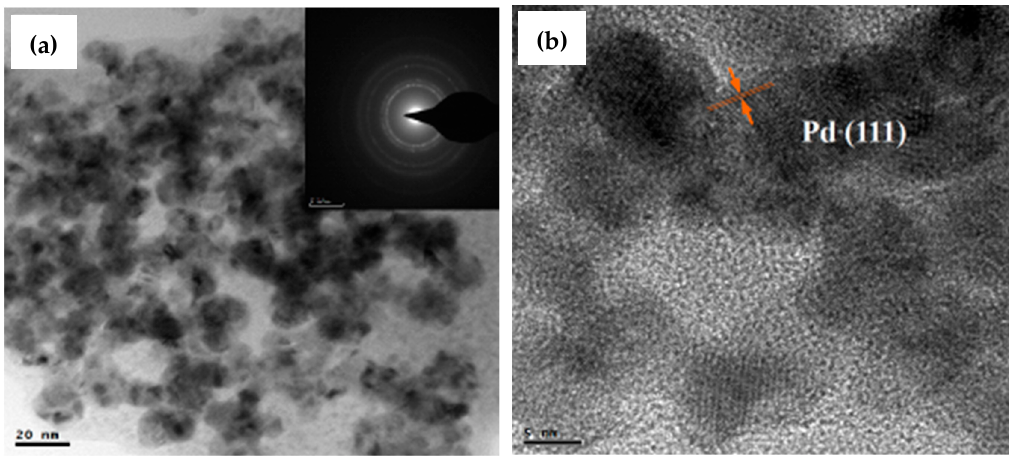
Figure 5. TEM ( a ) and HR-TEM ( b ) of Pd/Ni electrode.